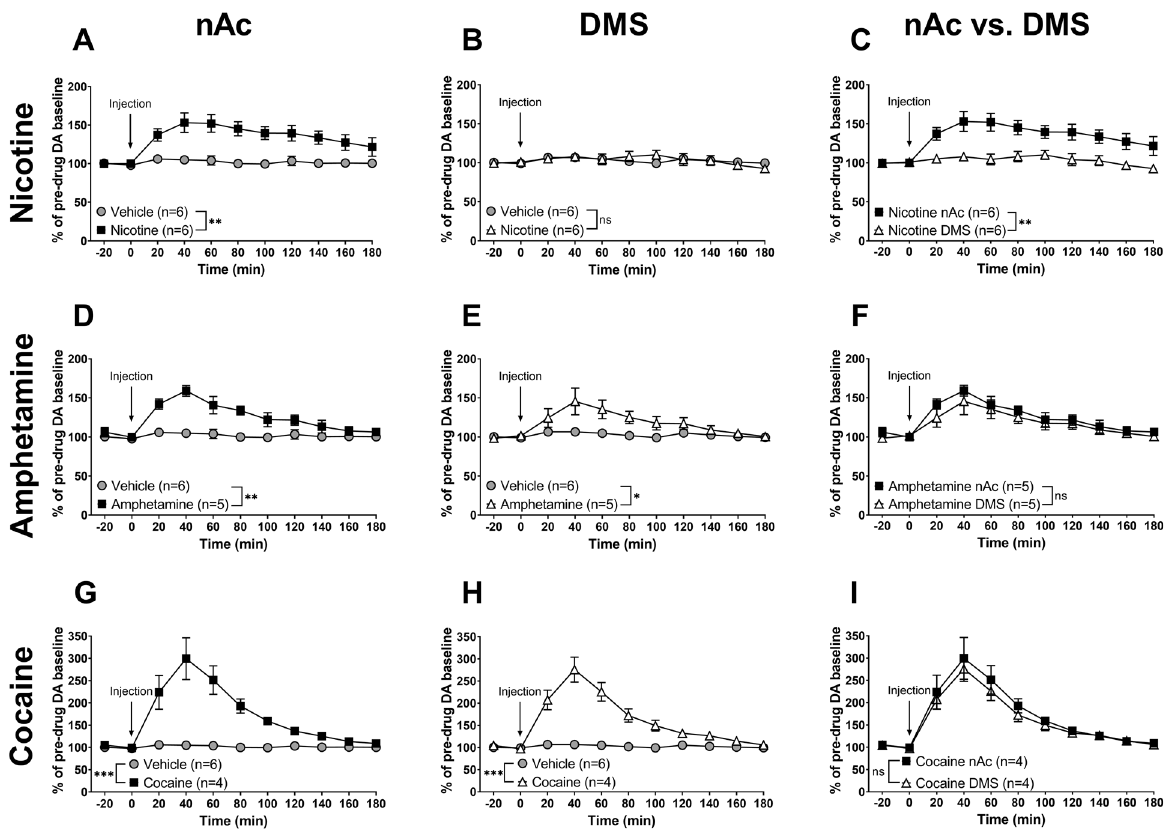
Fig. 2 Differential DA release in the nAc and DMS by nicotine as compared to amphetamine and cocaine. A – C Systemic administration of nicotine (0.36 mg/kg s.c.) resulted in a signi fi cant elevation in extracellular DA in the nAc, but not in the DMS. D – F Amphetamine administration (0.5 mg/kg i.p.) produced a signi fi cant elevation of DA both in the nAc and in the DMS, with no signi fi cant difference between the two regions. G – I Cocaine (15 mg/kg i.p.) induced a robust DA elevation in the nAc and the DMS, with no signi fi cant difference in the DA response between the two regions. All values are presented as means ± SEM. n number of rats. * p < 0.05, ** p < 0.005, *** p <